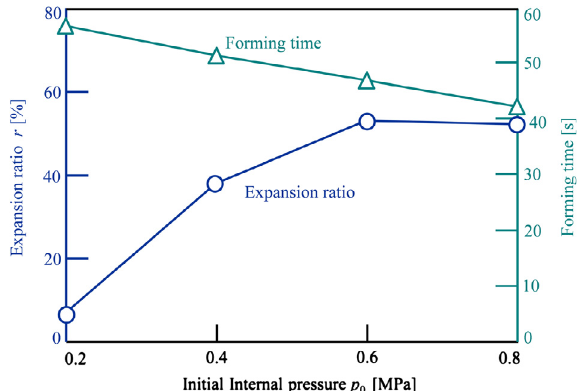
Figure 7. Variations in expansion ratio and forming time up to the bursting with initial internal pressure for J = 38 A/mm 2